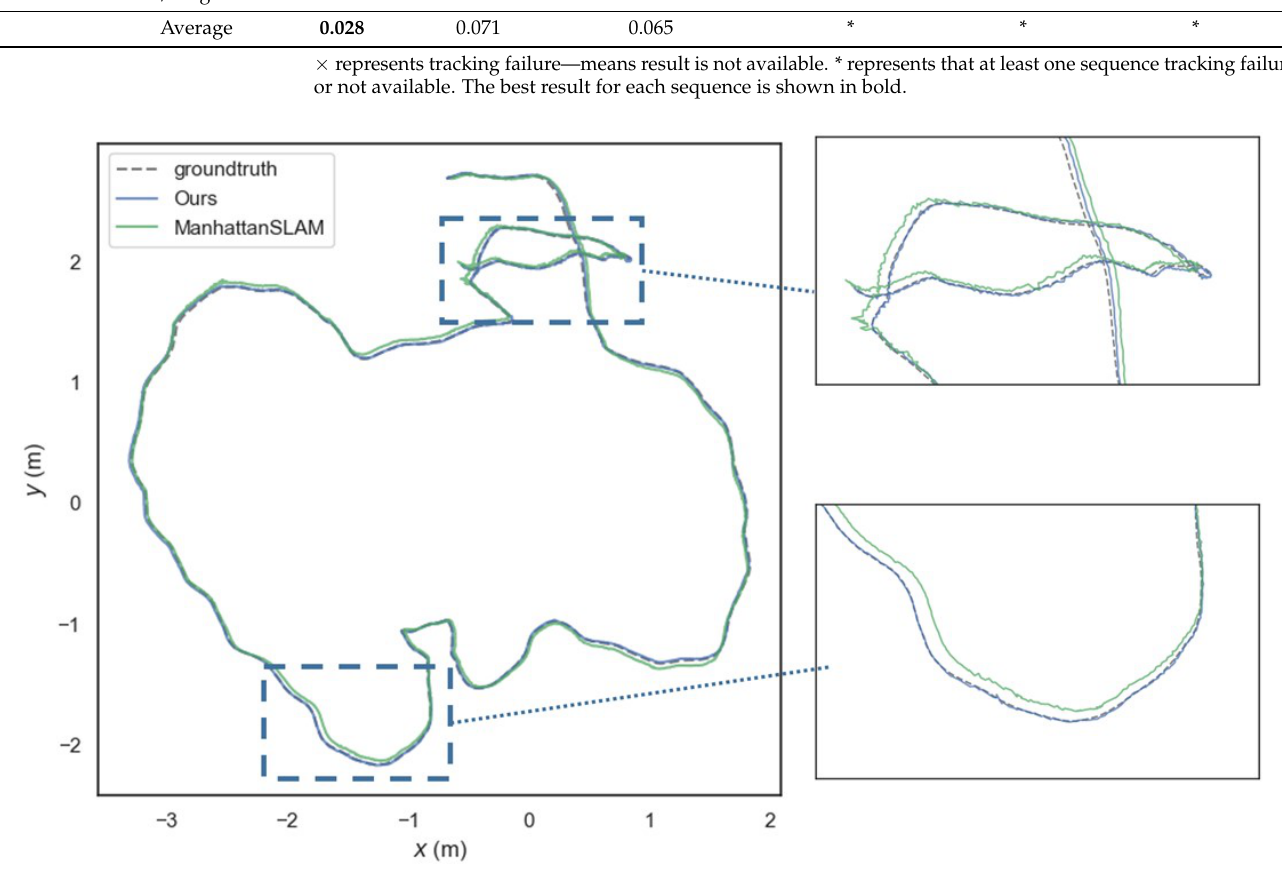
Figure 9. Left : Comparison of ATE RMSE (M) for sequence fr1/xyz, fr1/desk, fr2/xyz, fr2/desk. Right : The percentage of MFs detected from each sequence.